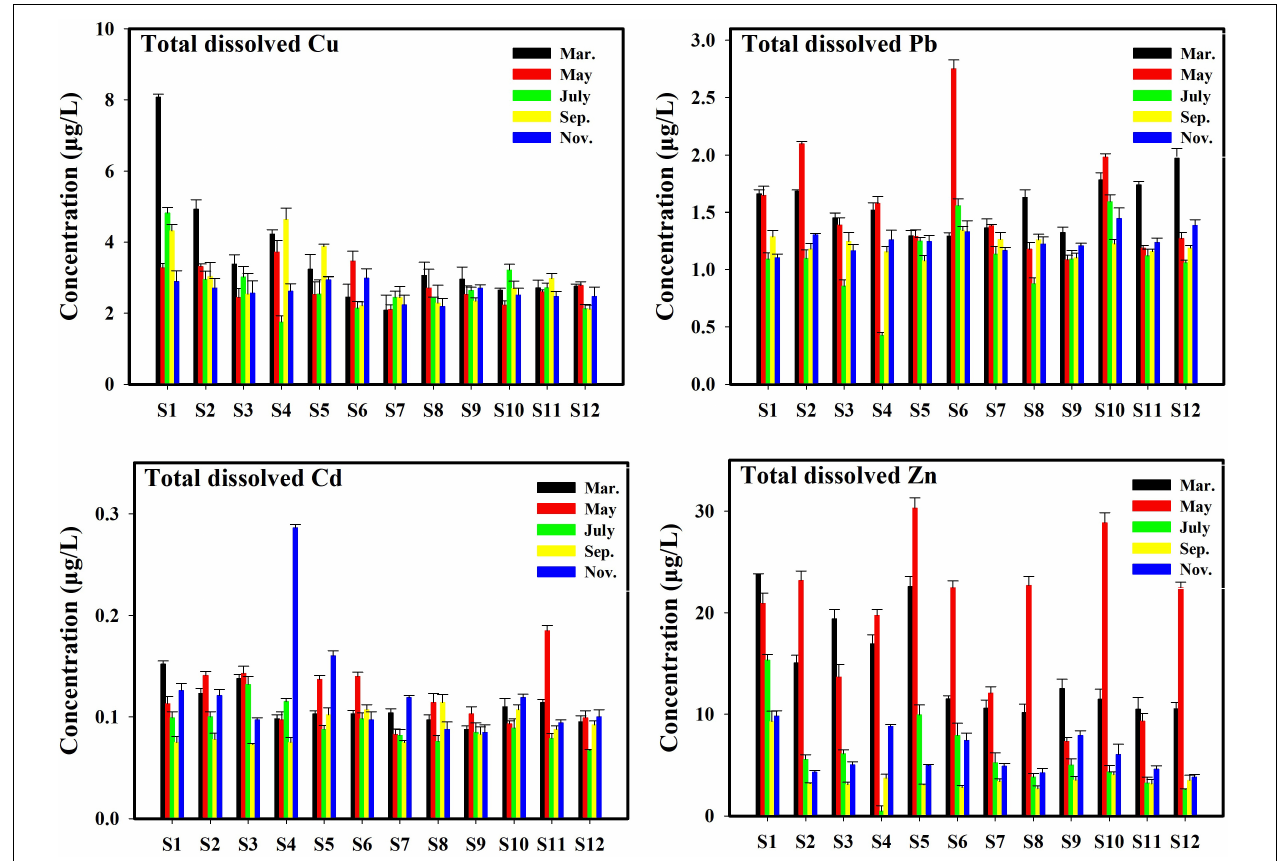
FIGURE 3 | Concentrations of total dissolved TMs at all sampling stations in different